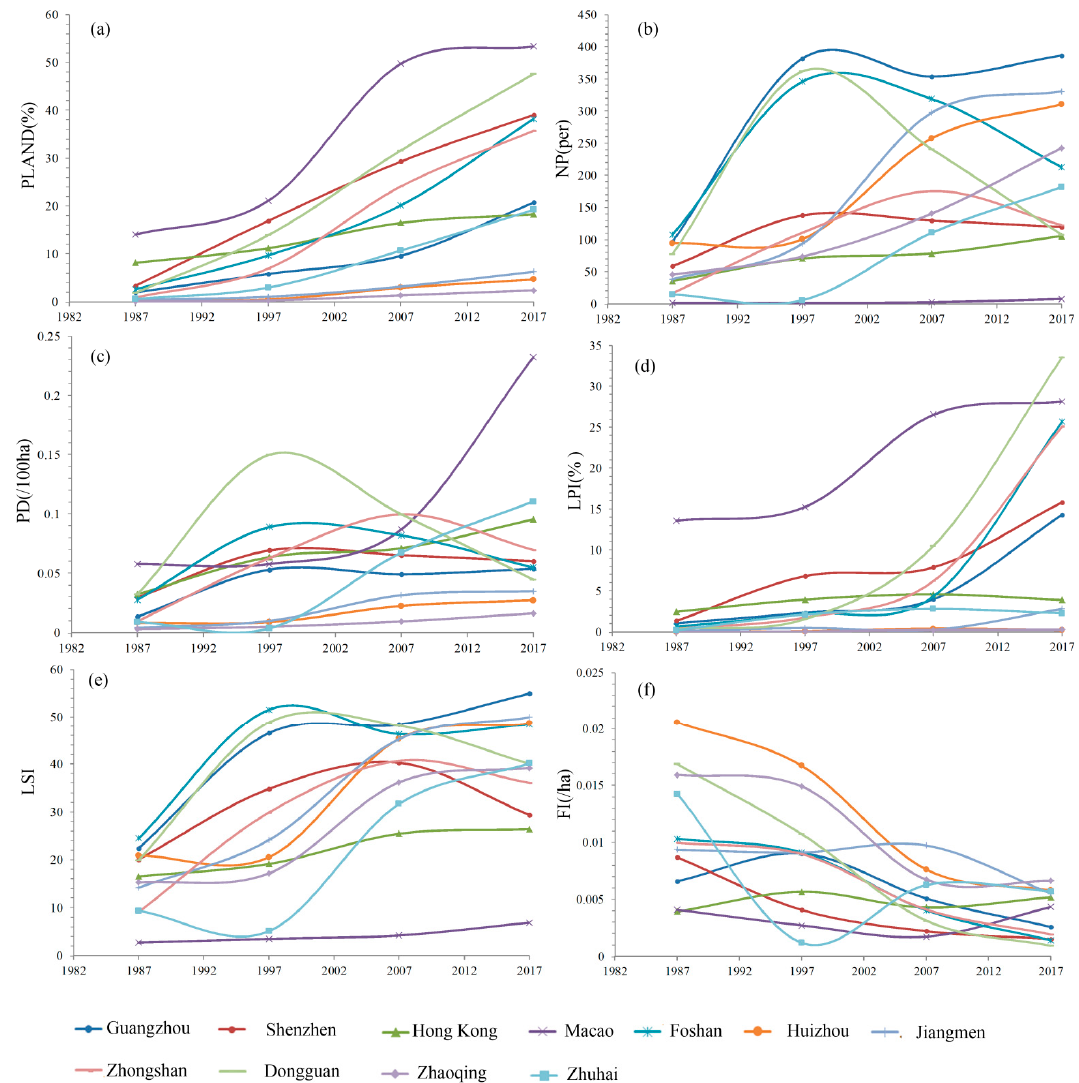
Figure 7. The landscape metrics for the urban land of 11 cities in the GBA between 1987 and 2017: ( a ) percentage of landscape (PLAND, %); ( b ) number of patches (NP, per year); ( c ) patch density (PD, per 100 ha); ( d ) largest patch index (LPI, %); ( e ) landscape shape index (LSI); and ( f ) fragmentation index (FI, per